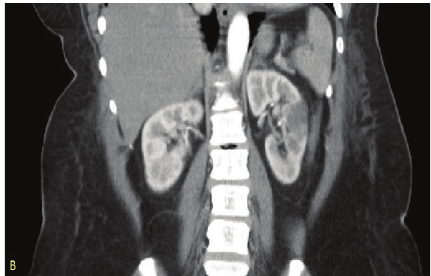
Figure 2: Coronal view of the abdomen showing an area of hypoenhancement marked by an arrowconsistent withrenal infarct.